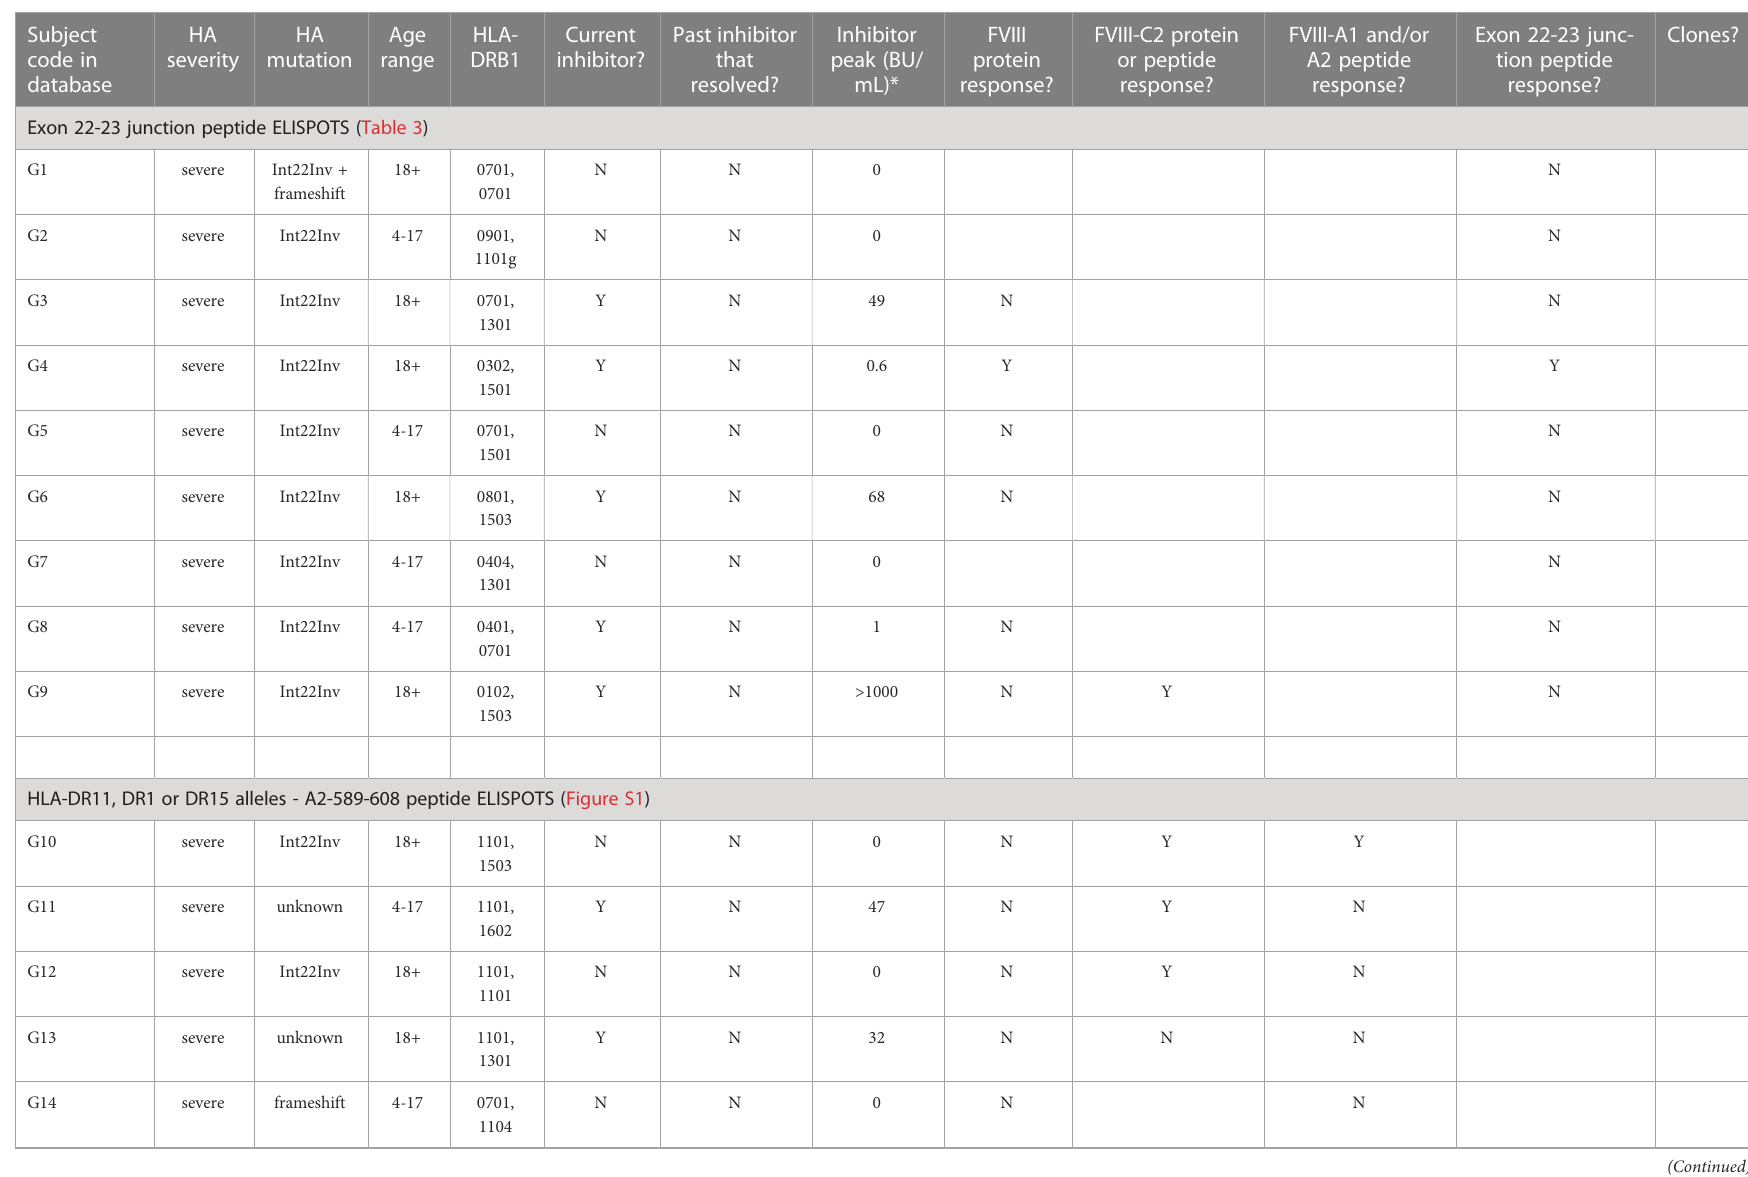
TABLE 4 Per-subject summary of clinical, demographic and experimental